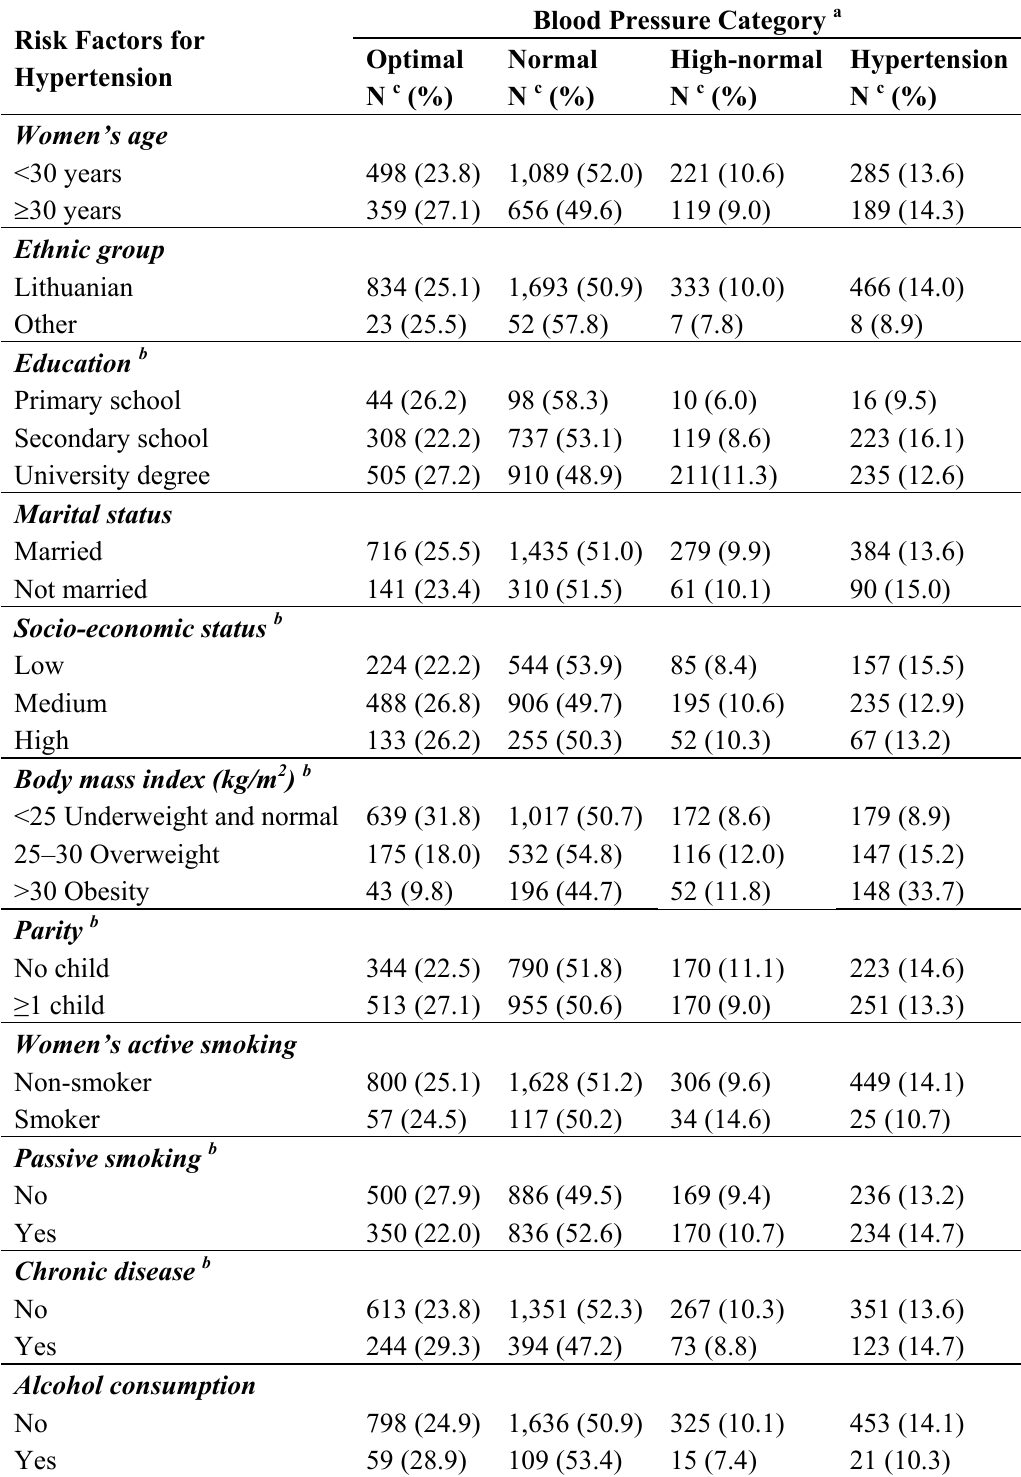
Table 1. Distribution (%) of women’s characteristics by blood pressure